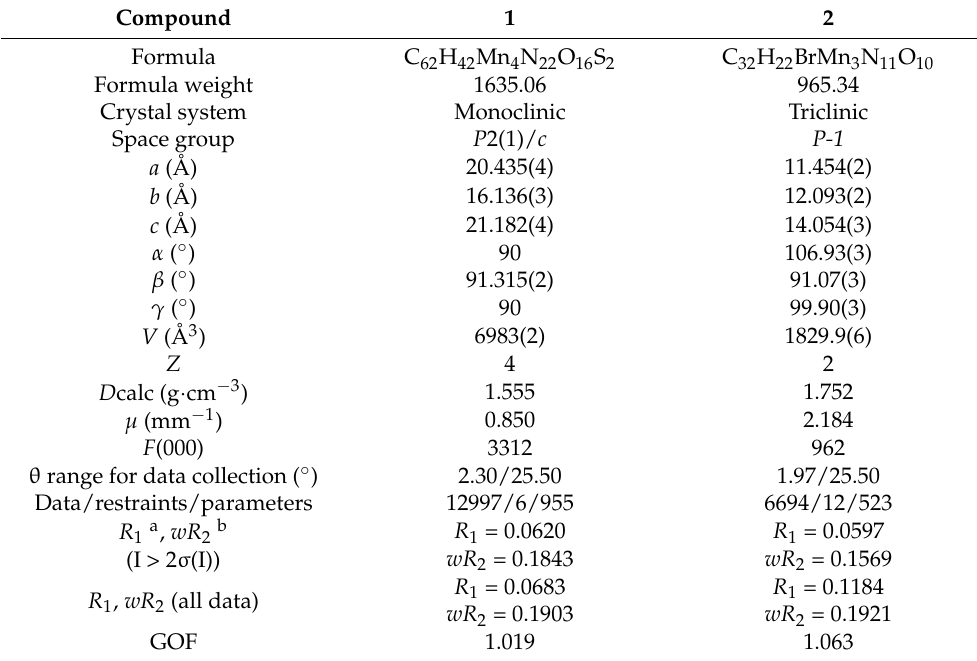
Table 1. Crystallographic parameters for compounds 1 – 2